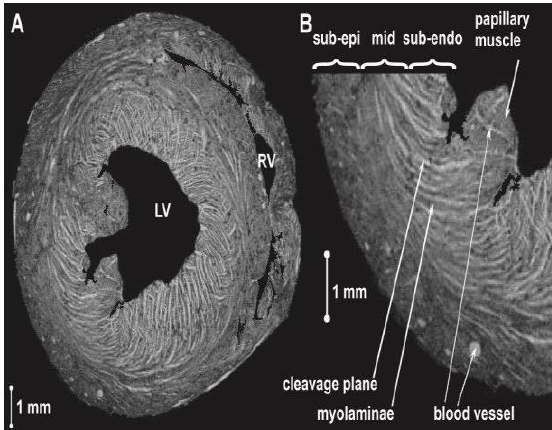
Figure 2. Laminar architecture in a near equatorial short- axis slice (MRI dataset C1HR, resolution of 25 25 37m).